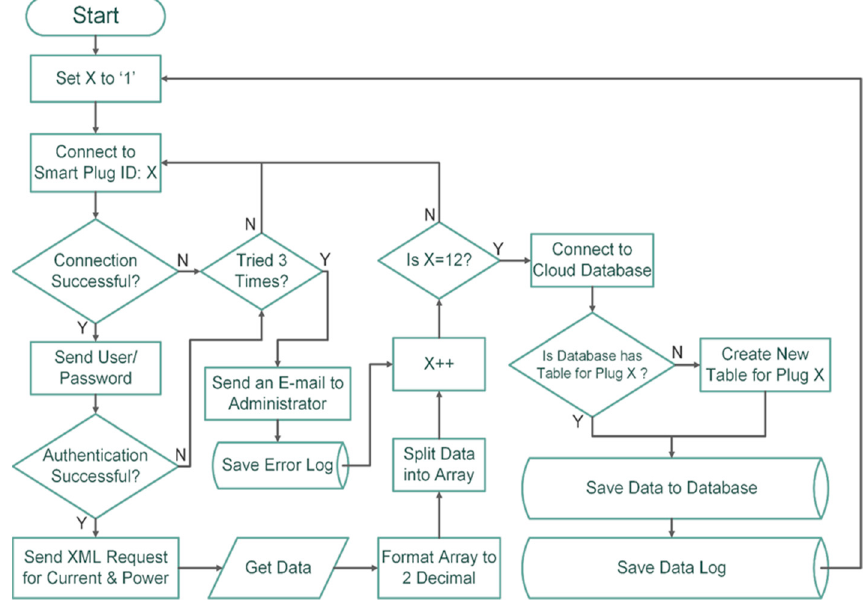
Figure 2. The flowchart of the developed Java software.